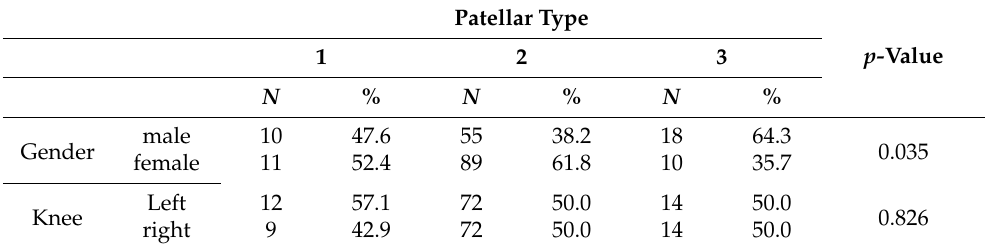
Table 3. Knee injury prevalence by patellar type.